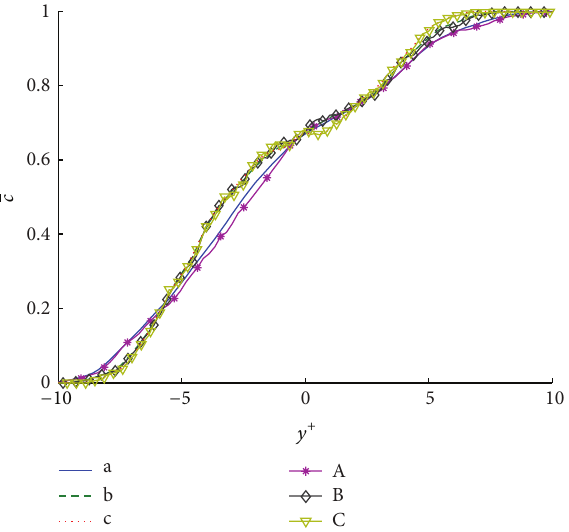
Figure 4: Mean concentration a cross profiles at various crosswise locations ( 𝑥 ∗ = 137 , 𝑥 ∗ = 228 , and 𝑥 ∗ = 319 ) for Sc = 1 (a, b, and c) and Sc = ∞ (A, B, and